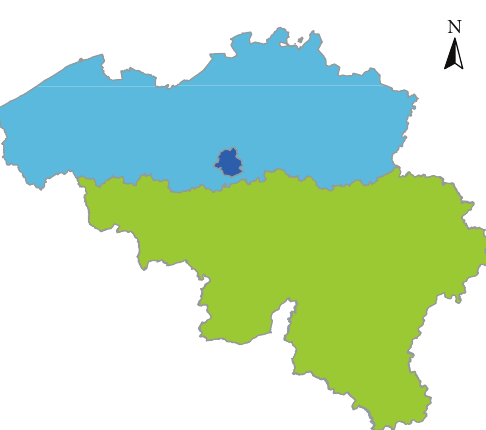
FIGURE 1: Map of Belgium, with in the north the Flemish part, in the south the French part, and Brussels as the dark blue region close to the border of het two other regions.